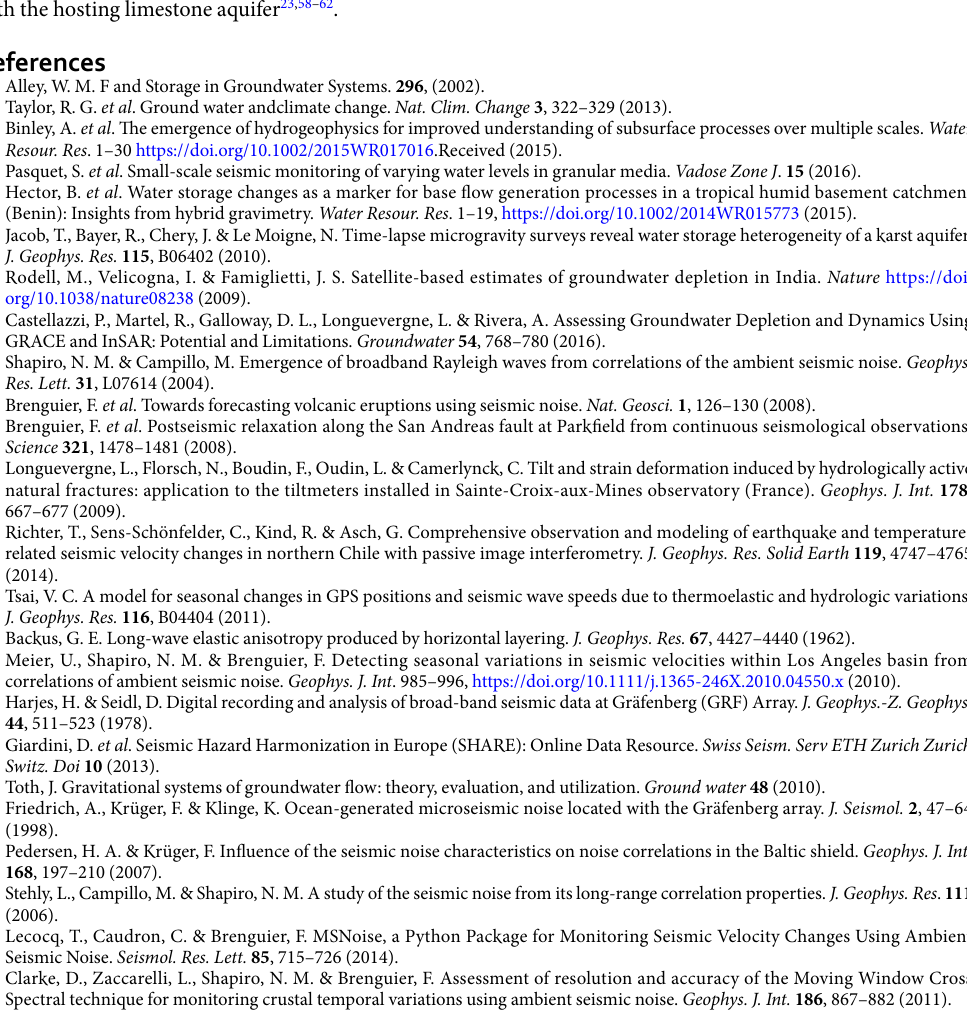
14 Scientific REPORTS | 7: 14241 | DOI:10.1038/s41598-017-14468-9